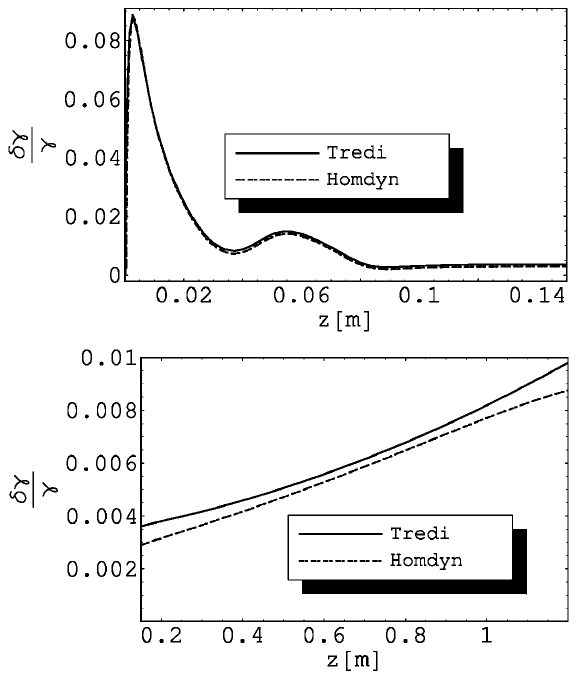
FIG. 7. Relative energy spread in the rf gun (top panel) and ahead (bottom panel).